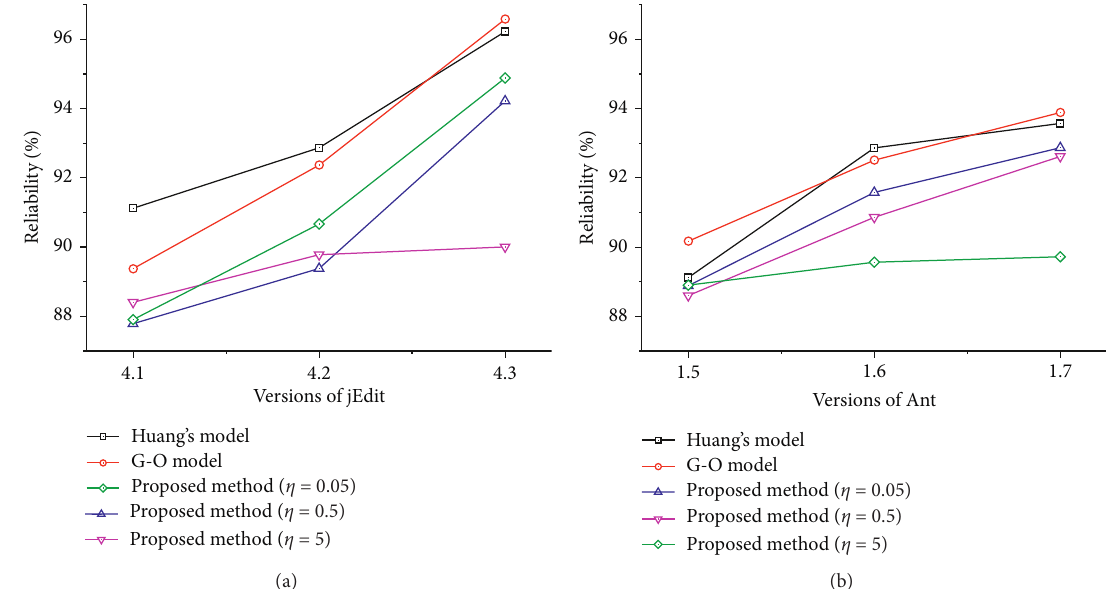
Figure 4: Reliability curves of the proposed method with different learning rates: (a) the learning rate η is set to 5, 0.5, and 0.05 on the target jEdit; (b) η is set to 5, 0.5, and 0.05 on the target Ant.